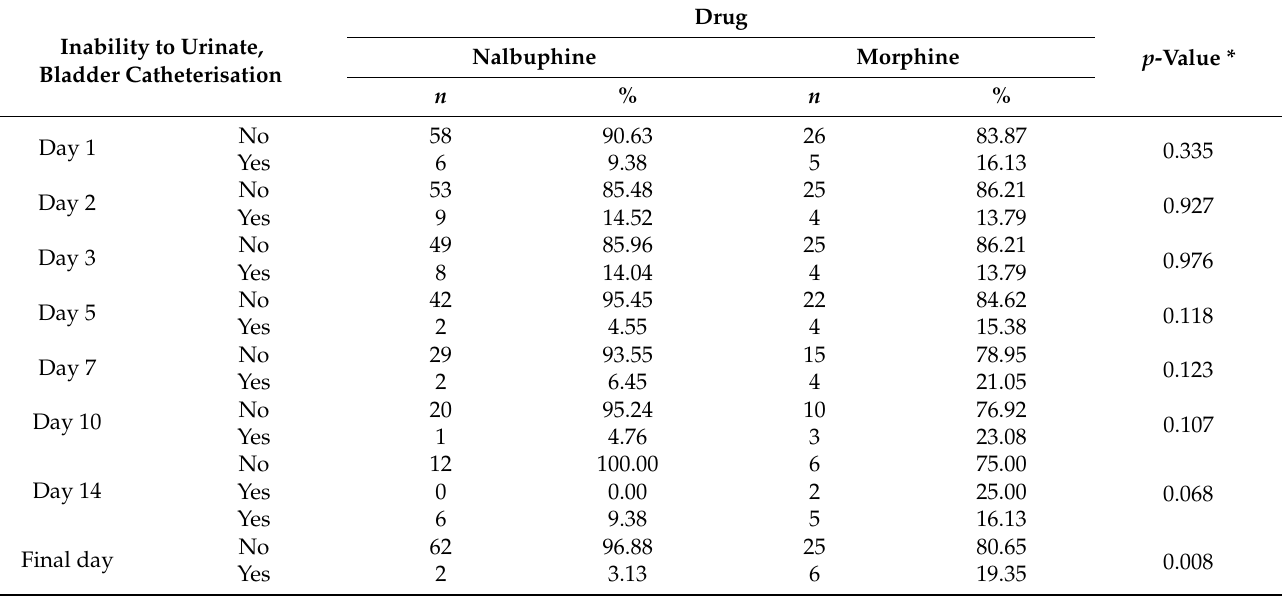
Table 4. Comparison of the incidence of urinary disturbances between patients receiving nalbuphine or